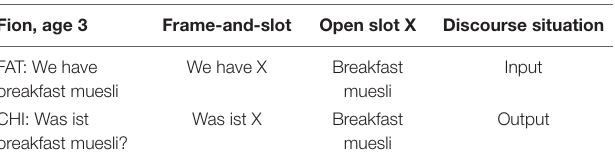
TABLE 1 | Example discourse priming.